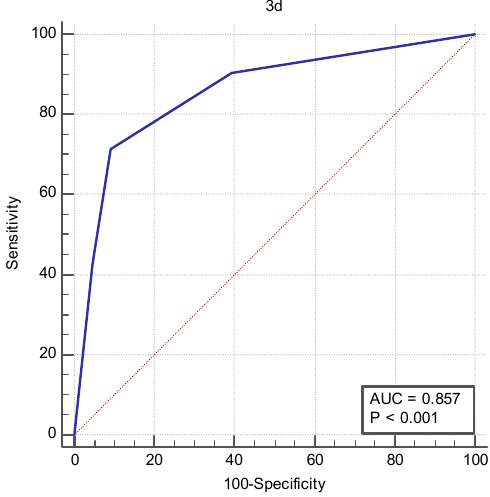
Figure 4. The area under the receiver operating characteristic (AUROC) curve for 3D Doppler as the only parameter in the evaluation of cases with Bethesda III and IV cytology compared to the pathology report.